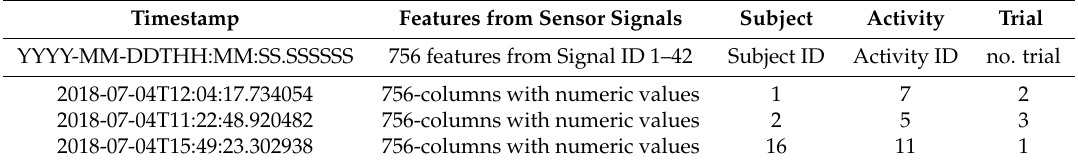
Table 9. Example of organization inside a CSV-file of the feature dataset. Each row represents one sample.